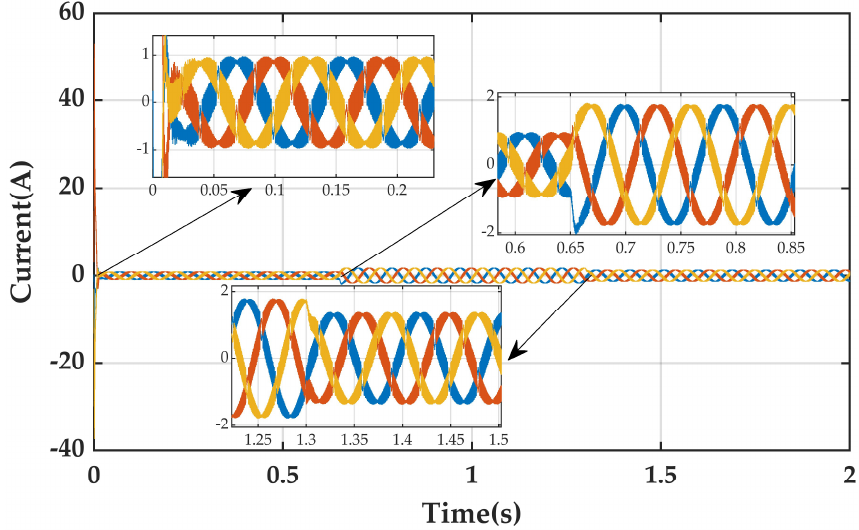
− CFDL − MFAPC controller.